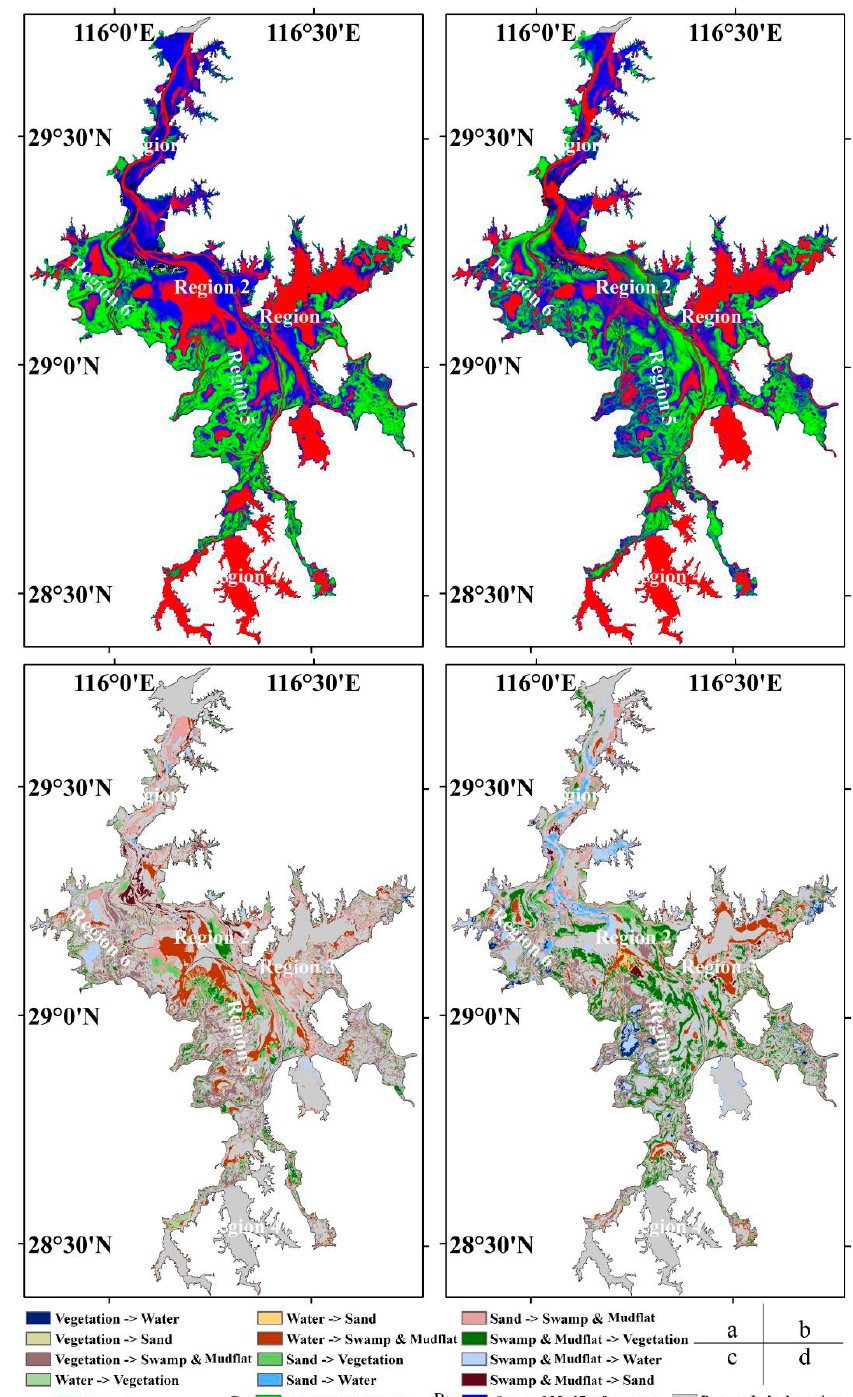
Figure 8. The RGB composite of the landcover type frequency map in the dry season (R: water frequency, G: vegetation frequency, B: swamp and mudflat frequency): ( a ) between 1973 and 2003 (pre-TGD period) and ( b ) between 2003 and 2019 (post-TGD period) in Poyang Lake. The transition map from ( c ) 1973–2003 and ( d ) 2003–2019.